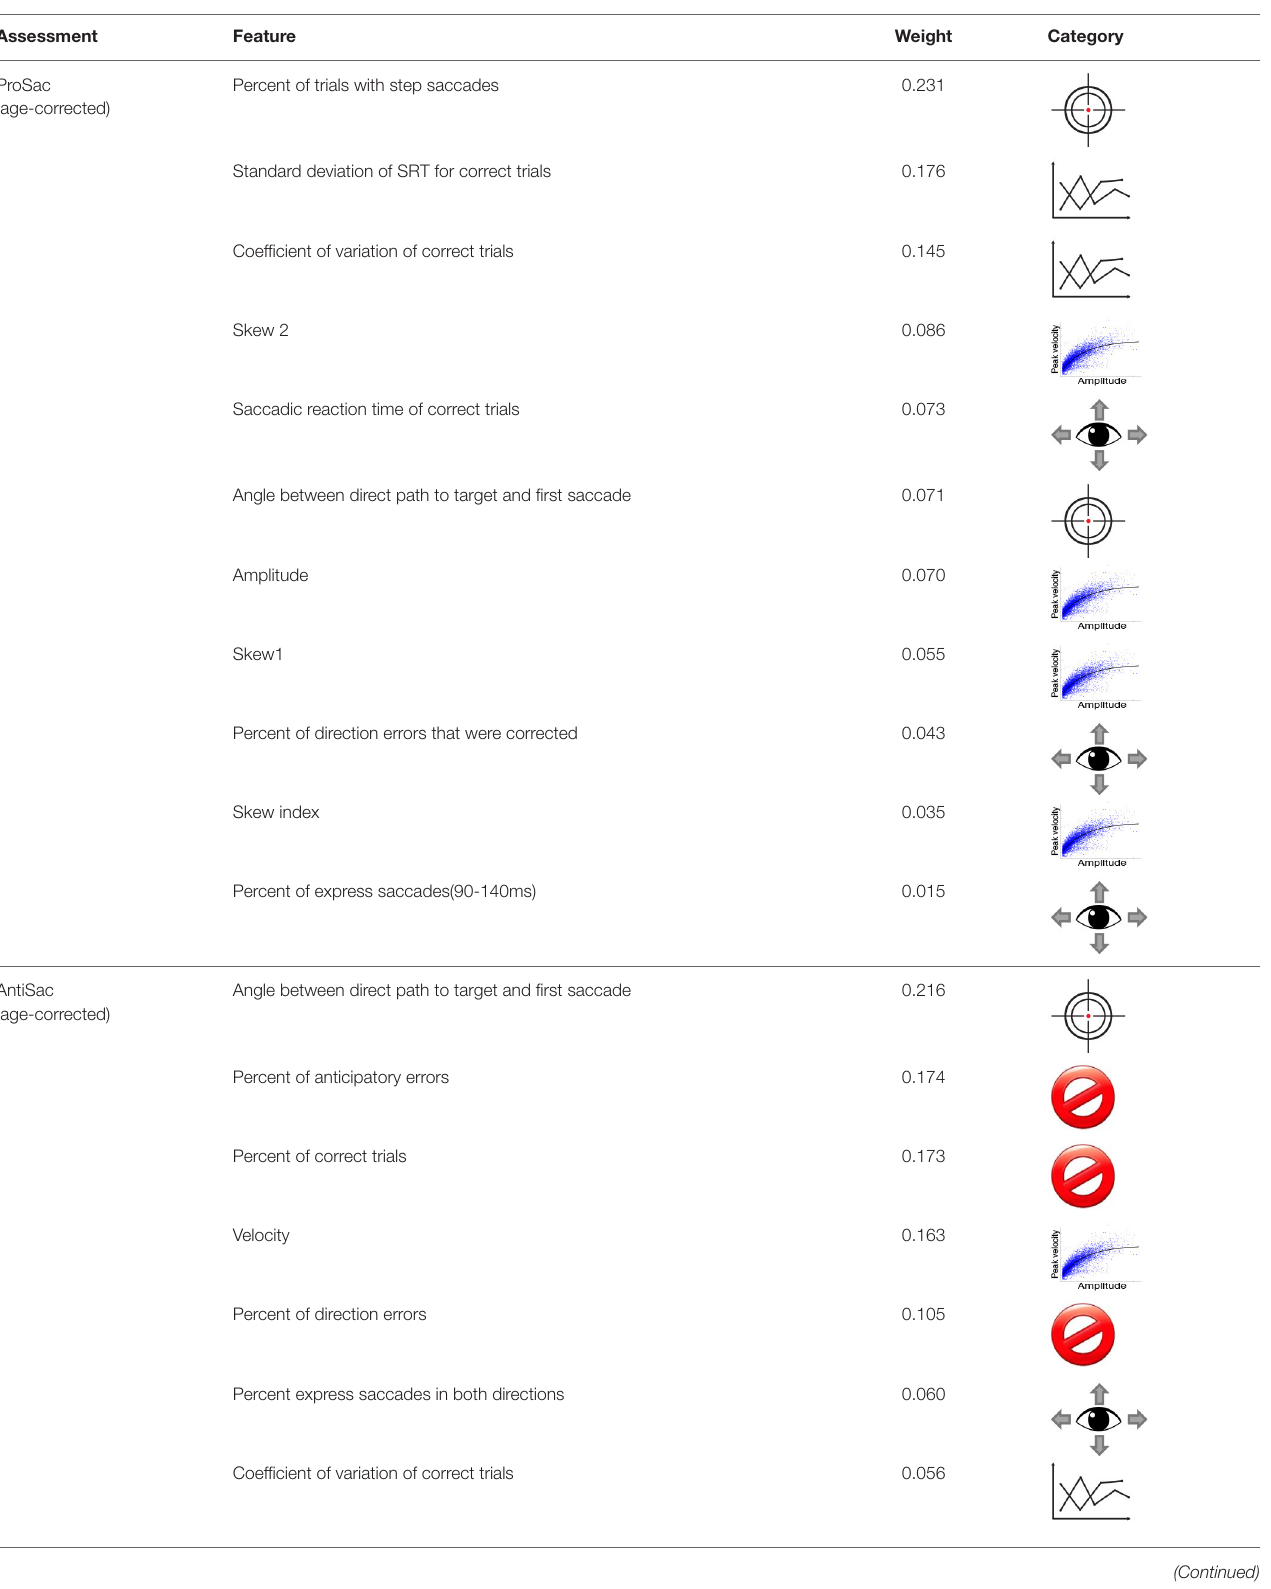
TABLE 4 | Selected features and normalized weights for single assessment